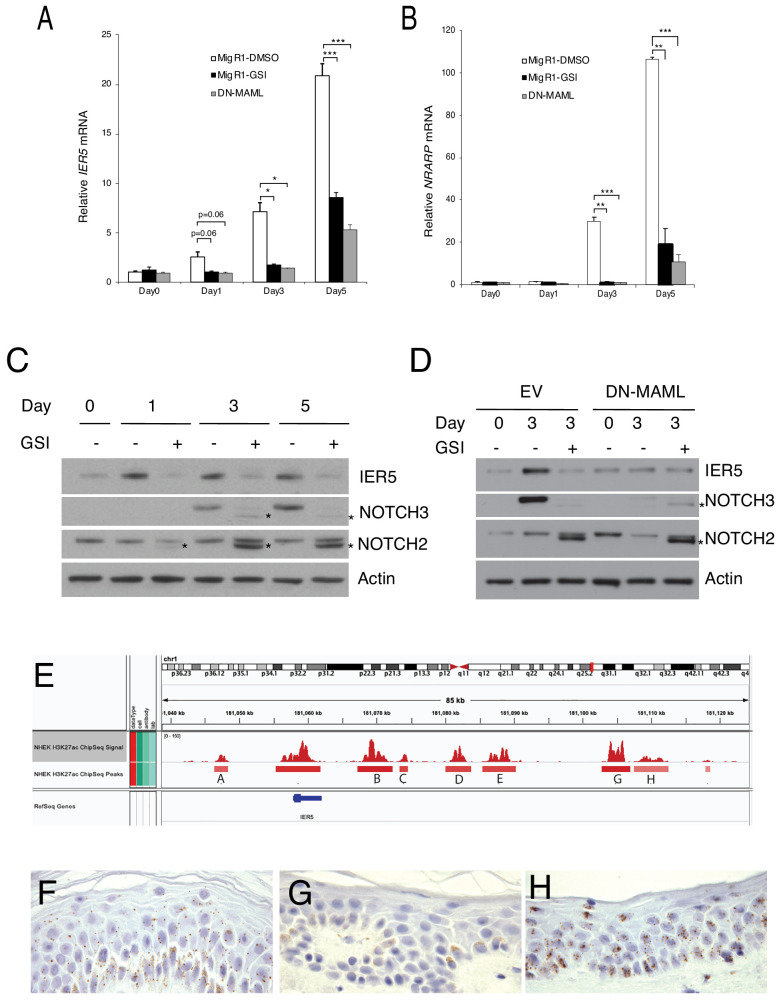
IER5 is regulated by Notch in non-transformed keratinocytes.(A, B) TERT-immortalized NOK1 keratinocytes transduced with either empty MigRI retrovirus or MigRI encoding dominant negative MAML1 (DN-MAML) were grown in low Ca2+ medium (Day 0) or were shifted to high Ca2+ differentiation medium for 1–5 days. IER5 and NRARP transcript abundance in biological replicates prepared in triplicate was measured by RT-PCR and normalized against GAPDH. Error bars represent standard deviations of the mean. *, p<0.05; **, p<0.005; ***, p<0.0005 (all two-tailed student t test). (C) Western blot showing changes in IER5, NOTCH2, and NOTCH3 polypeptides following transfer of NOK1 cells to differentiation medium in the absence (-) and presence (+) of GSI. Increased levels of smaller NOTCH2 and NOTCH3 polypeptides consistent with ADAM-metalloprotease cleaved products seen in differentiation medium in the presence of GSI are denoted with asterisks. (D) Western blot showing changes in IER5, NOTCH2, and NOTCH3 polypeptides following transfer of NOK1 cells transduced with either empty MigRI retrovirus (EV) or MigRI retrovirus encoding DN-MAML1 to differentiation medium in the absence (-) and presence (+) of GSI. Increased levels of smaller NOTCH2 and NOTCH3 polypeptides consistent with ADAM-metalloprotease cleaved products seen in differentiation medium in the presence of GSI are denoted with asterisks. (E) H3K27ac landscapes near the IER5 gene body in normal human epidermal keratinocytes (NHEK cells). ChIP-Seq data are from ENCODE. (F-H) Detection of IER5 transcripts in normal human epidermis by in situ hybridization (ISH). (F) IER5-specific probe; (G) DapB-specific negative control probe; (H) PPIB-specific positive control probe. Positive signals correspond to brown spots in cells that are counterstained with hematoxylin.